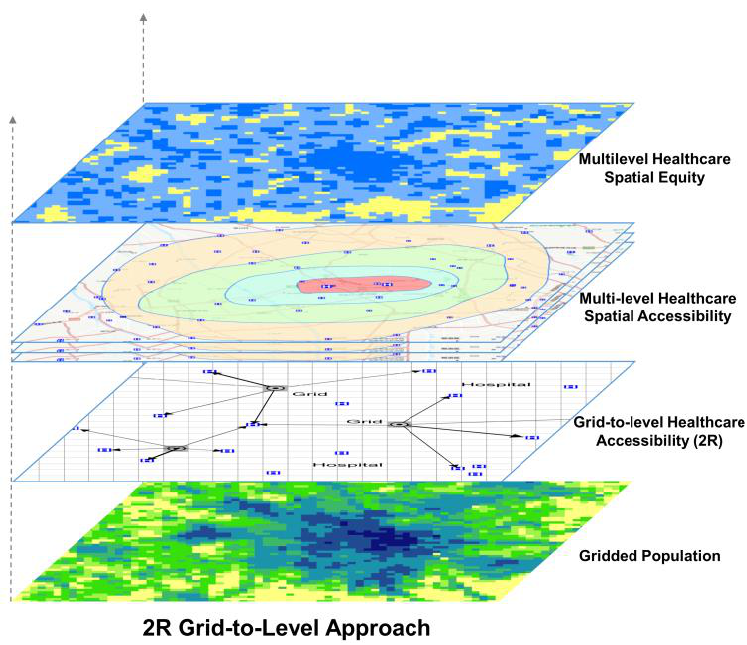
Figure 1. 2R Grid-to-level approach.